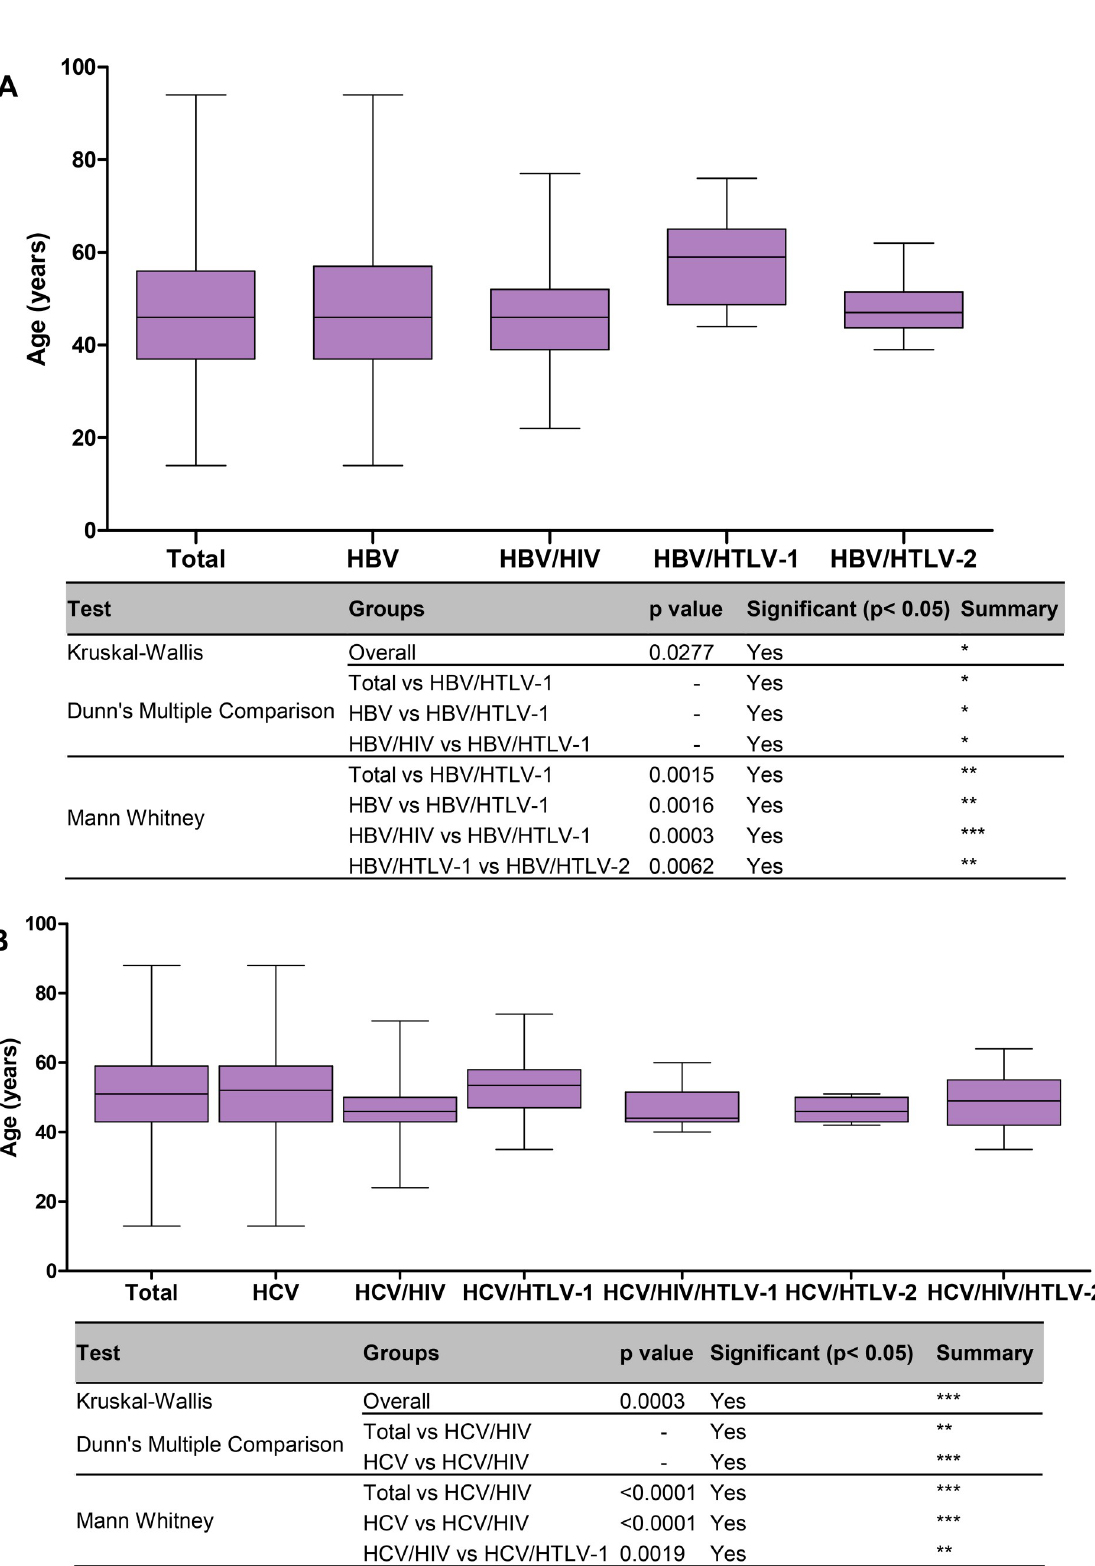
Fig 1. Median age of patients with hepatitis B (A) and hepatitis C (B) according to the type of viral infection and coinfection. The Kruskall-Wallis test was used for statistical analysis (three groups or more), complemented with Dunn’s Multiple Comparison test, and the Mann-Whitney U-test (two groups). p -values depicted as asterisks correspond to: � , p < 0.05; �� , p � 0.01; ��� p � 0.001. https://doi.org/10.1371/journal.pntd.0008245.g001 PLOS NeglectedTropical Diseases | https://doi.org/10.1371/journal.pntd.0008245 May 26,